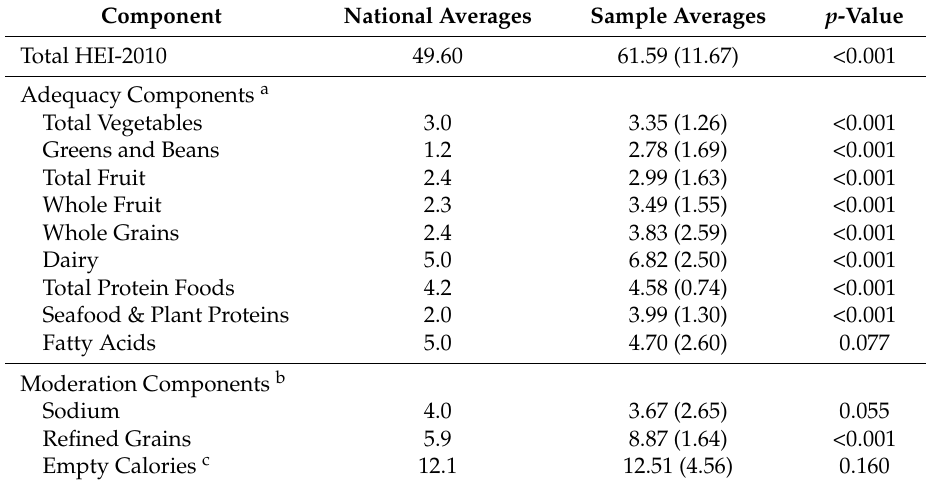
Table 3. Healthy Eating Index (HEI) Component Scores among Cancer Patients Compared to the National Population in